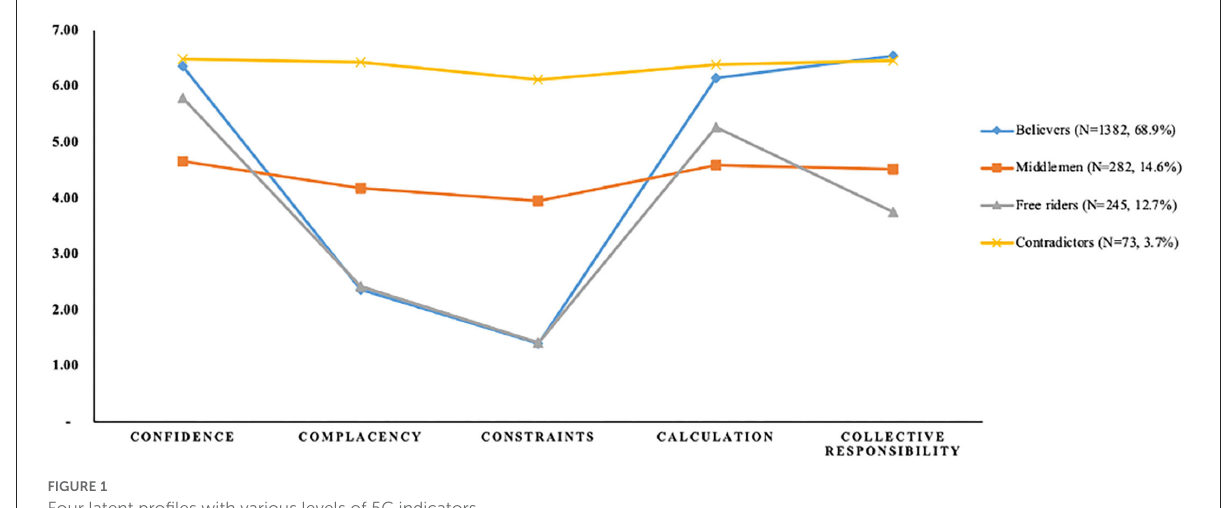
FIGURE1 Four latent profiles with various levels of 5C